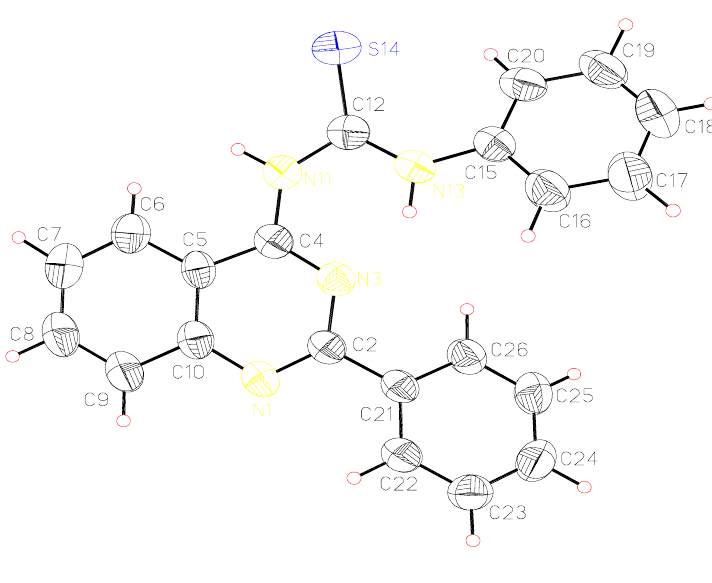
Figure 2: The ORTEP diagram of compound 7f.